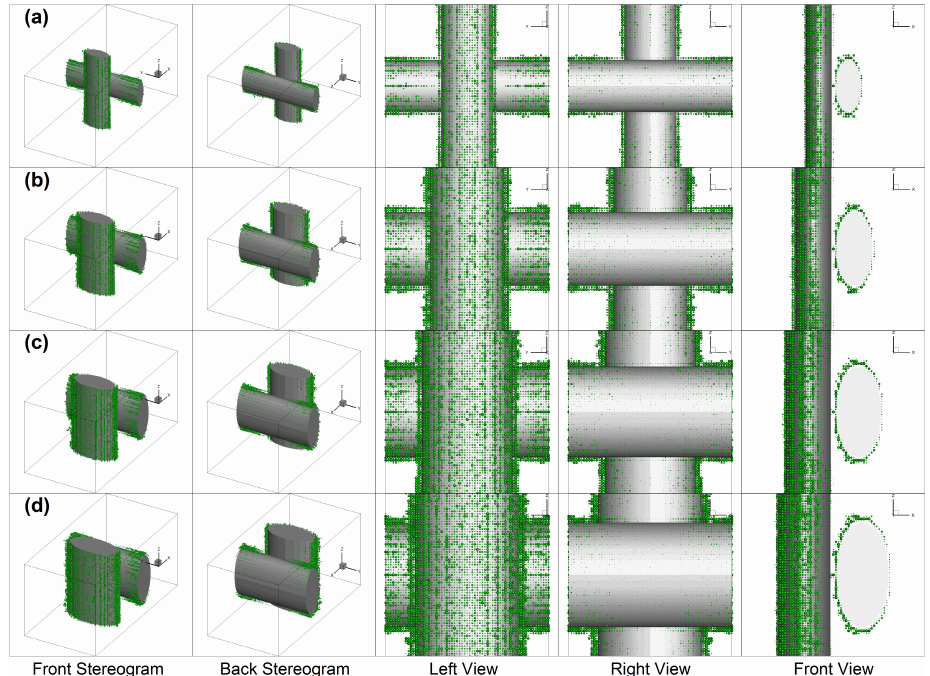
Figure 10. Dendrite structures with different packing densities: ( a ) Case 7, ɑ = 2.5%; ( b ) Case 2, ɑ = 5%; ( c ) Case 8, ɑ = 7.5%; ( d ) Case 9, ɑ = 10%.